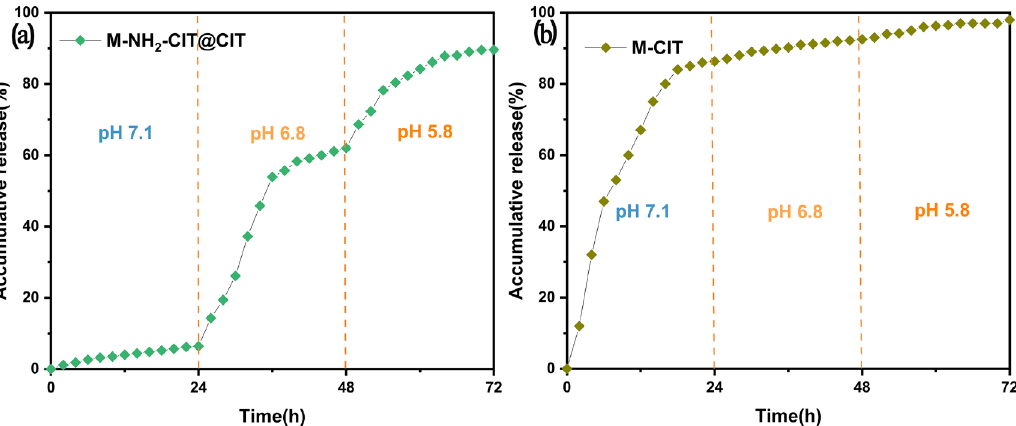
Figure 6 . CIT release curves of M-NH2-CIT@CIT ( a ) and M-CIT ( b ) at different pH val- Figure 6. CIT release curves of M-NH2-CIT@CIT ( a ) and M-CIT ( b ) at different pH values in vitro. ues in vitro.